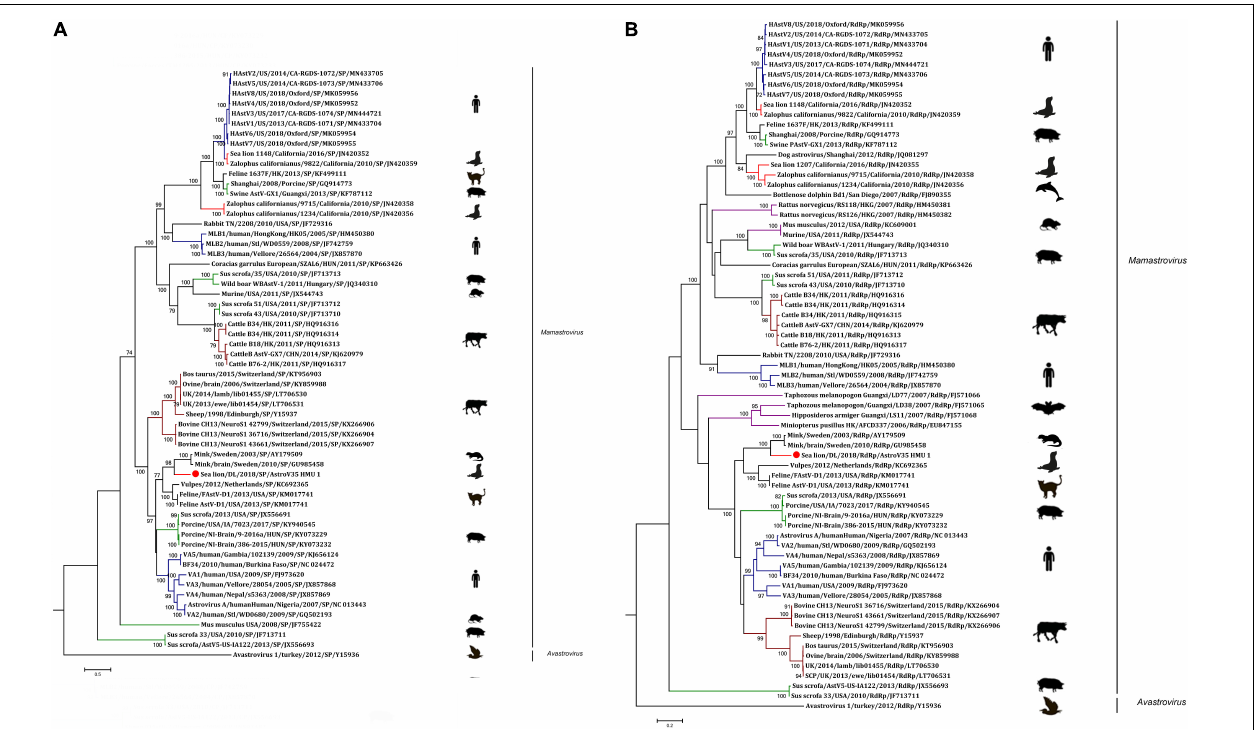
FIGURE 3 | (A) Phylogenetic analyses of SP regions of AstroV-HMU-1 with reference sequences. (B) Phylogenetic analyses of RdRp regions of AstroV-HMU-1 with reference sequences. Maximum likelihood (ML) mtREV with Freqs (+F) model and γ -distributed with invariant sites (G + I) with 1,000 bootstrap replicates performed in MEGA6. Novel astrovirus is indicated by red circles ( • ). Bootstrap values are shown on branches.